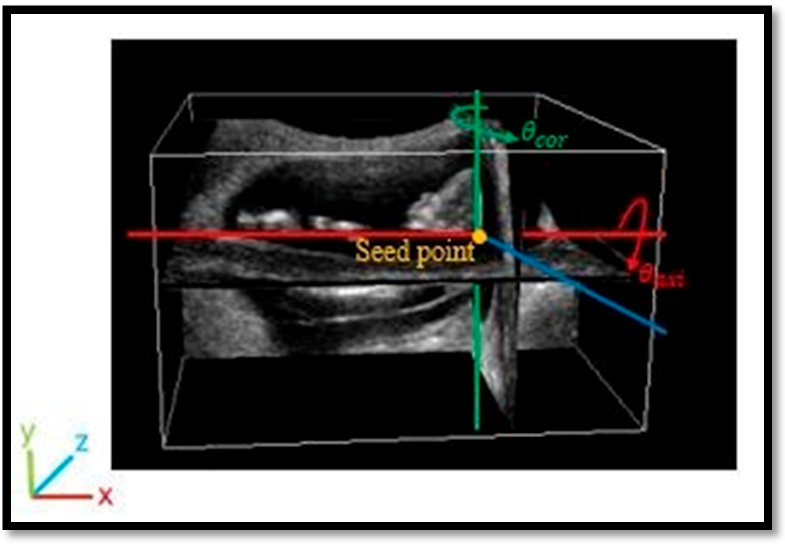
Figure 8. Illustration of labelling.